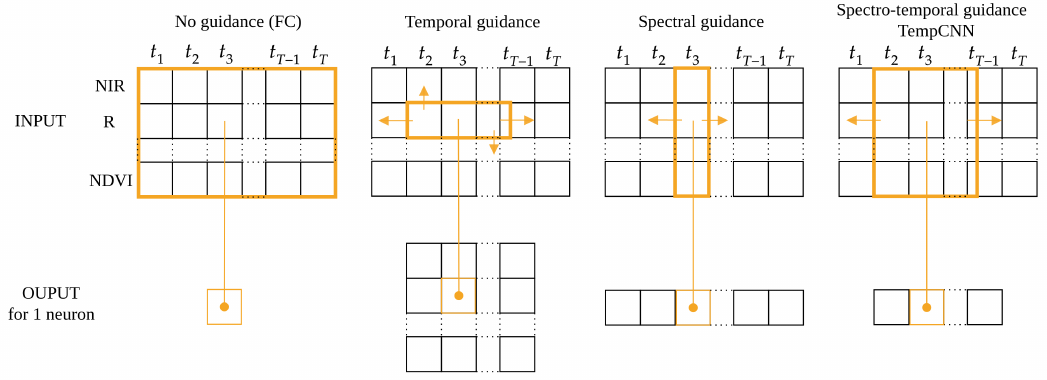
Figure 8. Types of guidance. The top row represents our input in a 2D array, whereas the bottom row represents the output of one neuron under each guidance